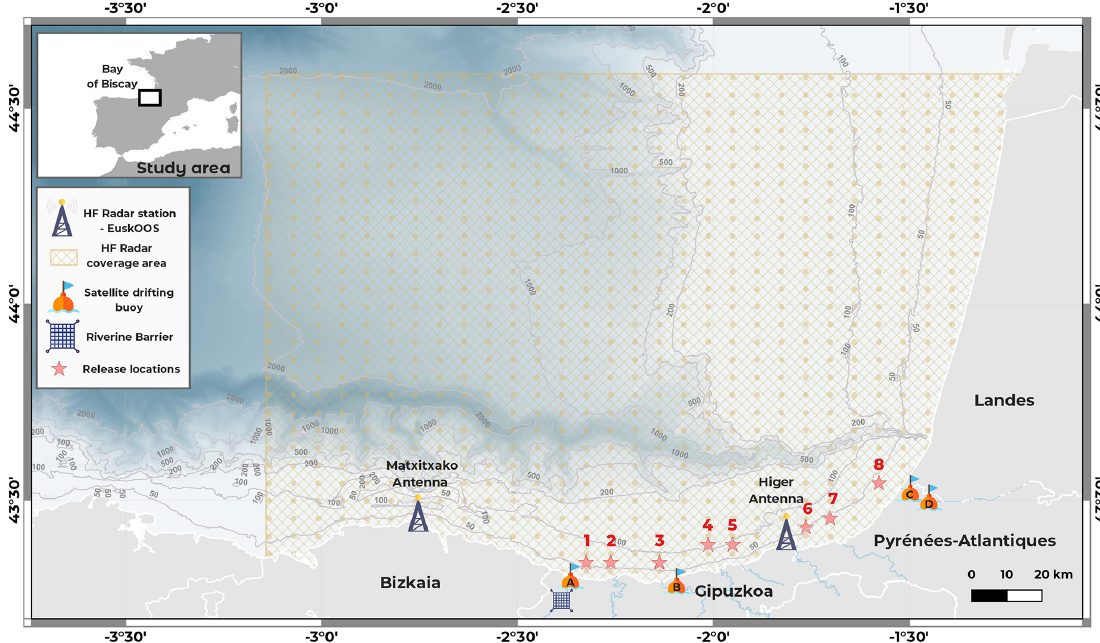
Figure 1. Study area with the release locations of the satellite drifting buoys and the riverine barrier. Dots in light yellow represent the nodes of the HF radar grid. Dots in orange represent the trajectories of the buoys. Numbers with stars in pink correspond to the particle releasing location for floating marine litter simulations: (1) Deba, (2) Urola, (3) Oria, (4) Urumea, (5) Oiartzun, (6) Bidasoa, (7) Nivelle, and (8) Adour